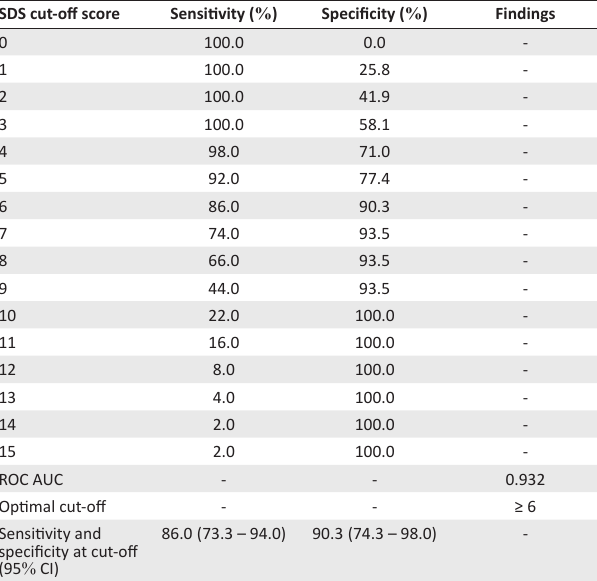
TABLE 2 : Representation of sensitivity and specificity of scores.